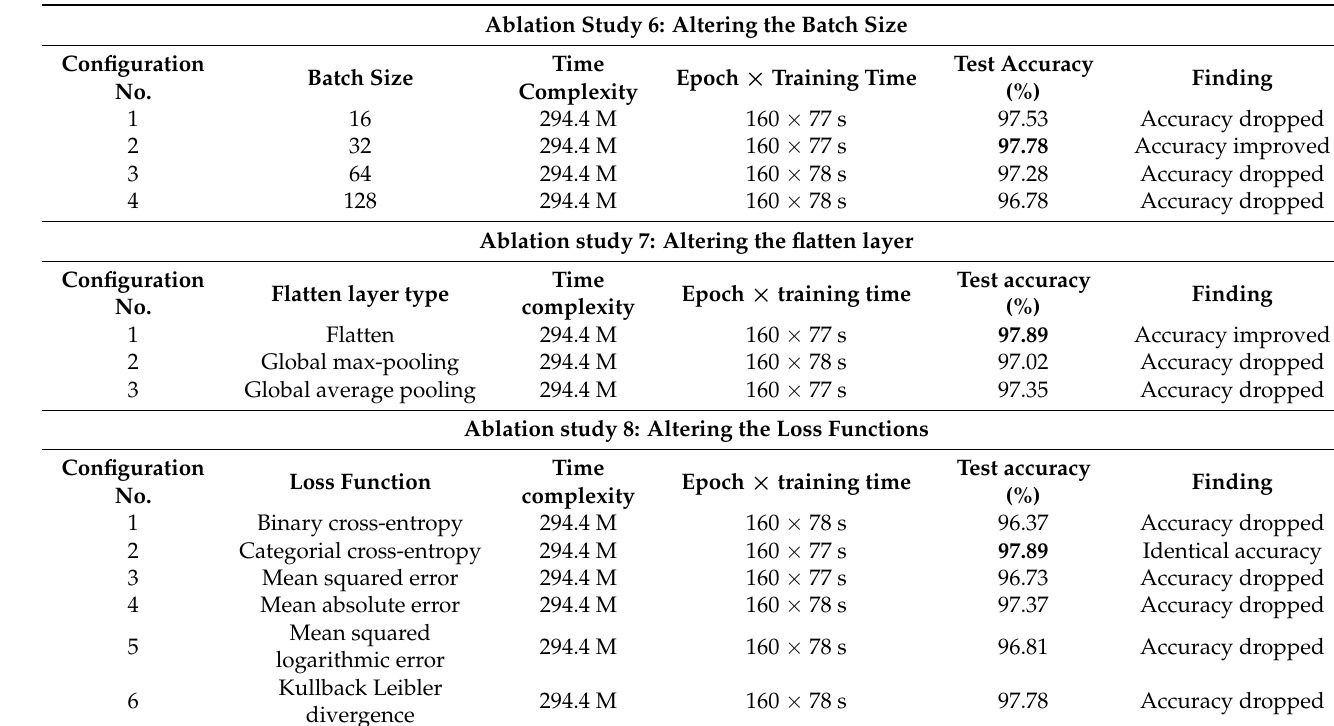
Table 4. Ablation study regarding model hyperparameters, loss function, and flatten